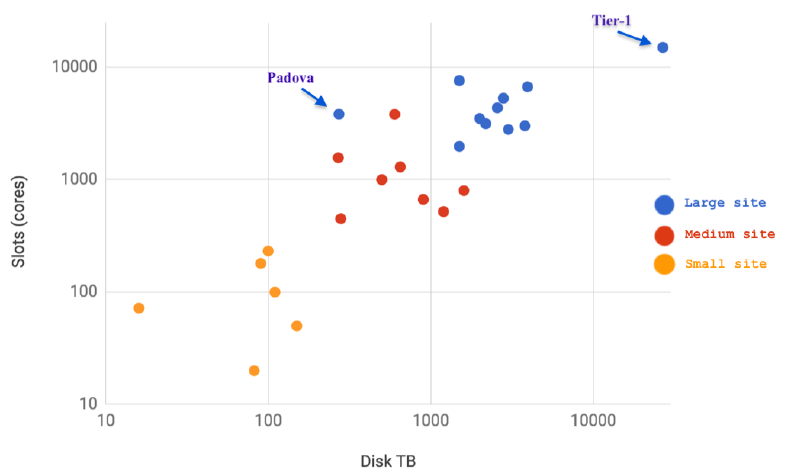
Table 1: INFN computing infrastructure (end of 2017)